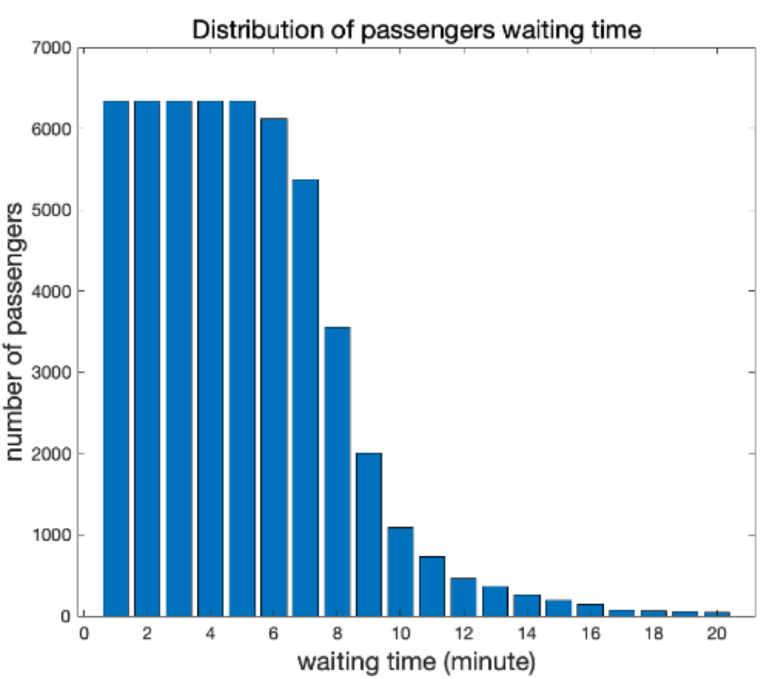
Figure 14. The histogram distribution of passenger waiting